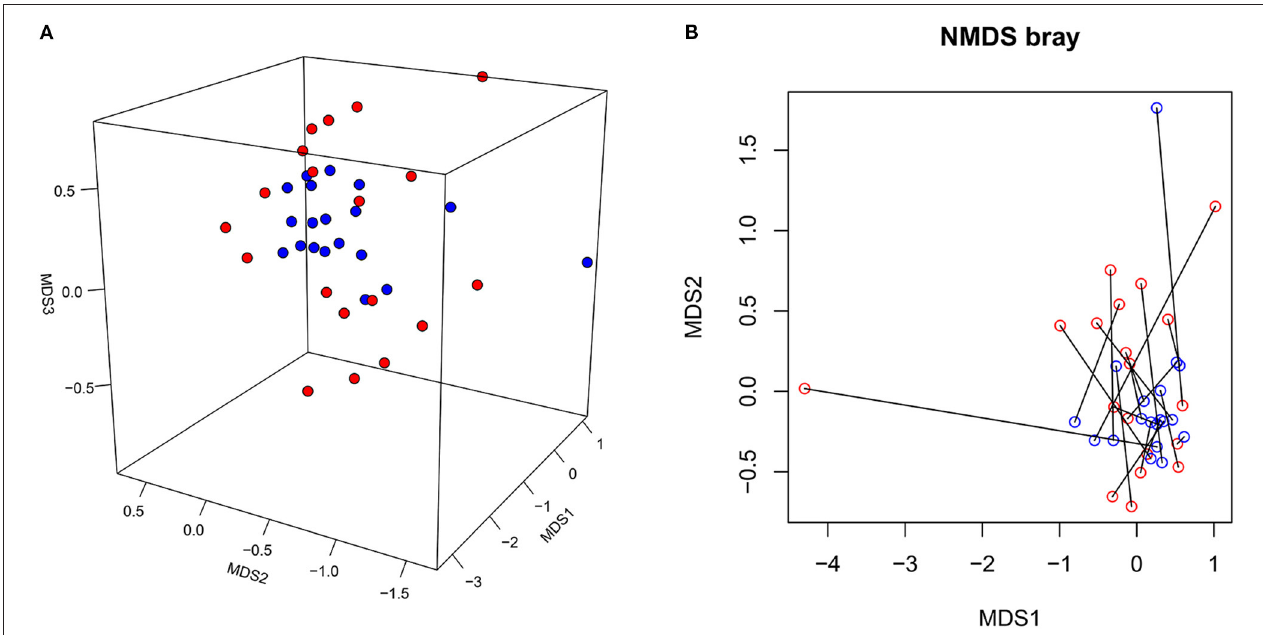
FIGURE 2 | The NMDS plot of gut microbiota from the SLE and HC groups. (A) The NMDS coordinates of SLE (red dot) and HC (blue dot) were plotted in 3D review. (B) The NMDS coordinates of SLE (red circle) and HC (blue circle) were re-plotted with samples from each disease-control pair